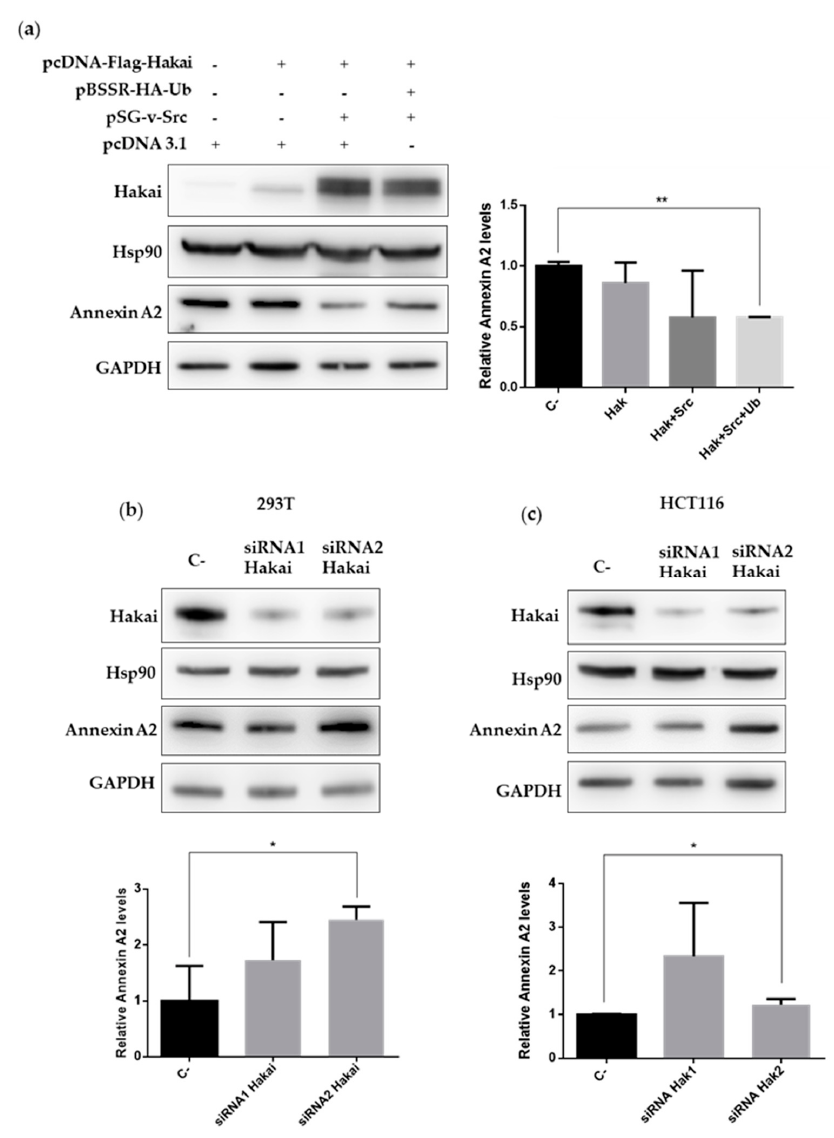
Figure 3. Hakai regulates Annexin A2 expression levels: ( a ) HEK293T cells were transiently transfected with pcDNA-Flag-Hakai (4 µg), pBSSR-HA-ubiquitin (3 µg) and pSG-v-Src (3 µg) plasmids for 48 h. Cells were harvested and the levels of endogenous Annexin A2 levels and Hsp90 were determined by western blot analysis (left panel) and quantified by densitometry (right panel). The effect of the indicated transfected siRNA-Hakai on Annexin A2 and Hsp90 levels were tested in 293T cells ( b ) and HCT116 ( c ). Whole-cell lysates were subjected to western-blotting 72 h after transfection (top) and protein expression was quantified by densitometry (bottom) using GAPDH as loading control for normalization. Relative quantification of Annexin A2 expression levels was graphically represented as Mean ± SEM for two independent experiments for panel a and three for panel b and c (* p < 0.05, ** p <